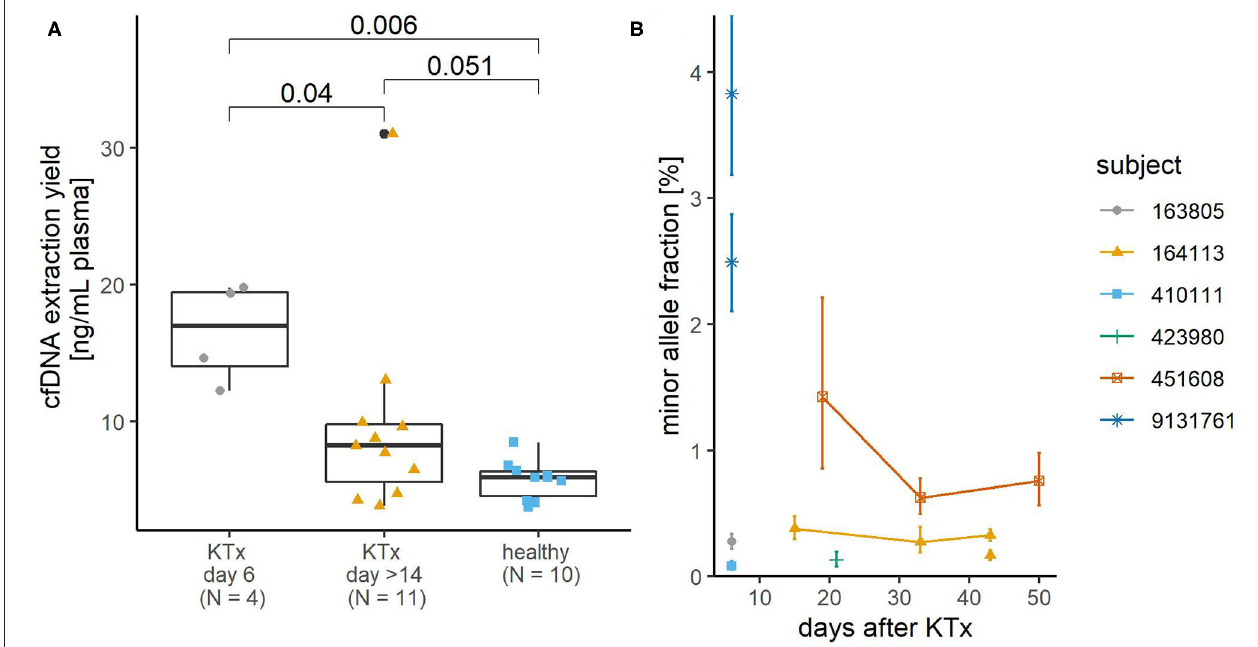
FIGURE 2 | Yield of plasma cfDNA from kidney transplant (KTx) patients and its donor-derived minor allele content. (A) The KTx cfDNA yield was higher than that of healthy volunteers. Colored shapes show the yields of each sample and boxplots summarize their distribution. P -values of pairwise comparisons using Mann Whitney U -test and Benjamini-Hochberg adjustment are shown. (B) Minor allele content in plasma cfDNA of KTx patients. The detected minor alleles are from the donor, but the zygosity status of the donor DNA is not known, so the exact proportion of donor-derived DNA would be 2-fold in the case of heterozygous donor DNA. For two samples (subject ID 9131761, 6 days after KTx and subject ID 164113, 43 days after KTx), the minor allele proportion was determined using two SNP assays, hence two values for the minor allele proportion of each sample. Error bars represent Poisson confidence intervals. In three cases where the confidence intervals are wider (subject ID 9131761, 6 days after KTx and subject ID 451608, 19 days after KTx), minor allele proportions were determined in non-preamplified cfDNA samples. In the other cases, ddPCR analysis was performed after targeted multiplex PCR preamplification of